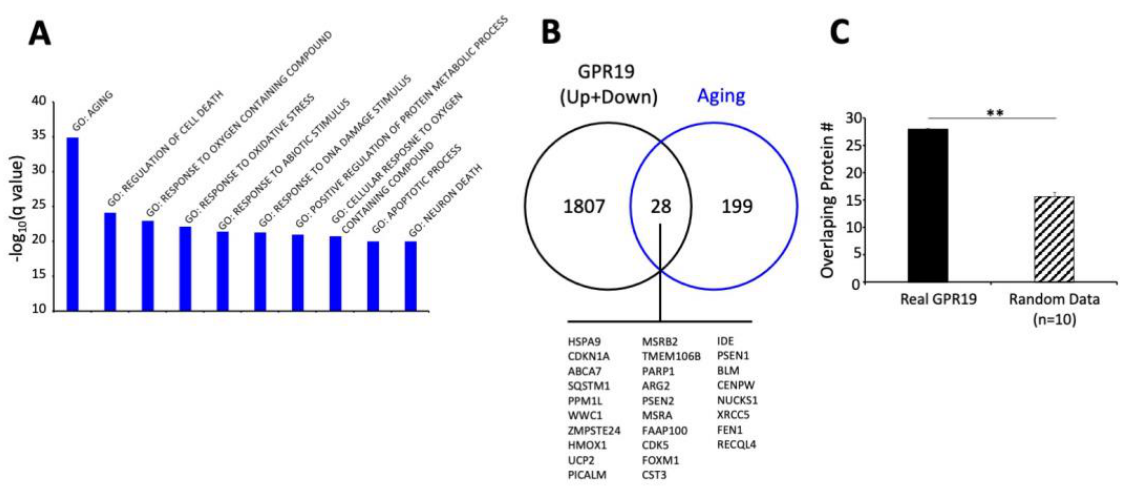
Figure 4. Aging-specific functionalities of GPR19-associated datasets. ( A ) Informatic benchmark analysis of an unbiased aging-specific dataset created using natural language processing. This specific resultant dataset (227 proteins) was then subject to MSigDB Gene Ontology (GO)—biological process enrichment analysis. GO annotations were only considered significant if populated by at least two independent proteins at an enrichment probability of <0.05. The most significantly populated GO term generated using this aging-specific dataset was GO: AGING (GO:0007568). ( B ) When comparing the protein contents of the specific aging dataset with the total GPR19 up plus down associated protein cohorts (Figure 1), 28 common proteins were found between these two data corpi. ( C ) This numerical level of association was highly significant as the numerical commonality between a random data set the same size as the aging dataset, and the total GPR19-associated dataset was only 15.7 + 0.81 (mean + SEM). ** indicates p <